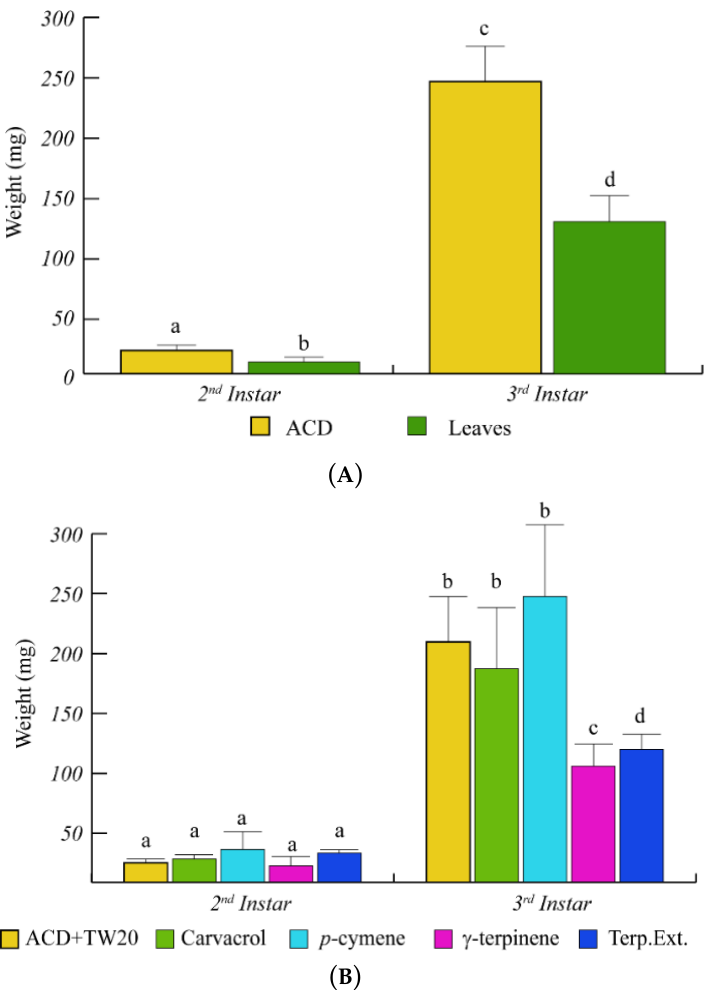
Figure 3. Weight variation of S. littoralis upon feeding on O. vulgare leaves and terpenoids. ( A) . Comparison of S. littoralis weight upon feeding on ACD or O. vulgare leaves. ( B ). Effect of terpenes extracted from O. vulgare leaves and some monoterpenes produced by O. vulgare on S. littoralis weight. ACD + Tween 20 was used as control. Bars indicate standard deviation. Different letters indicate significant ( p < 0.05) differences.